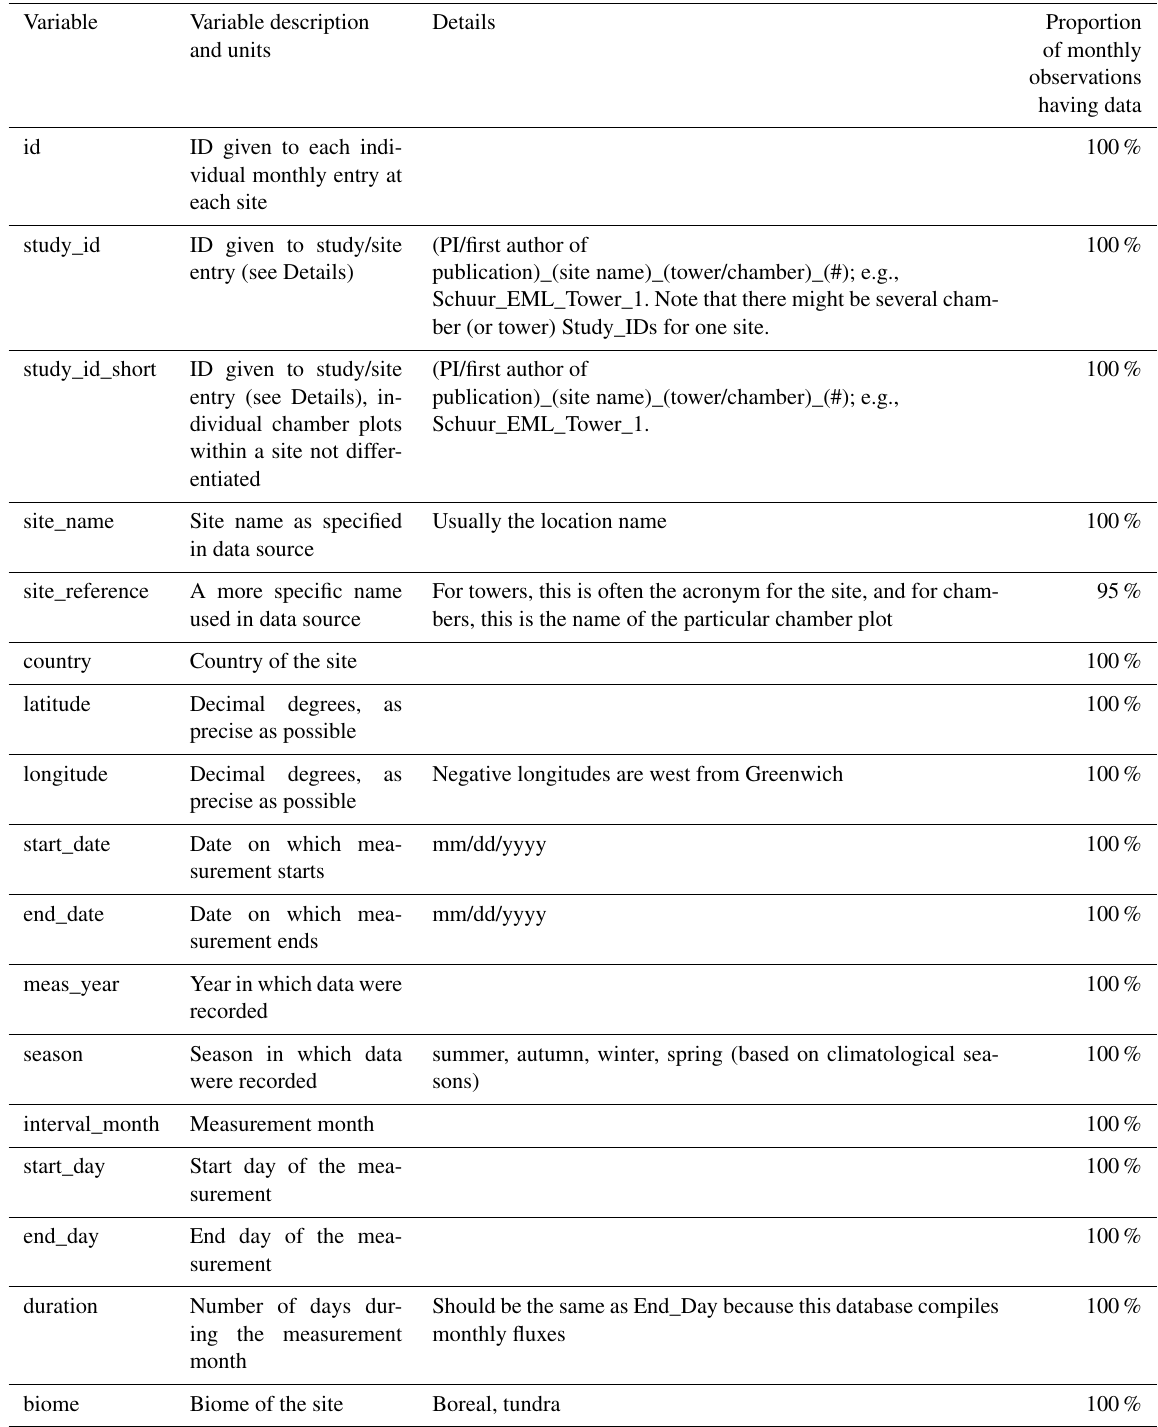
Table 2. Database variables and the proportion of monthly observations in each variable. There are in total 6309 monthly observations in the